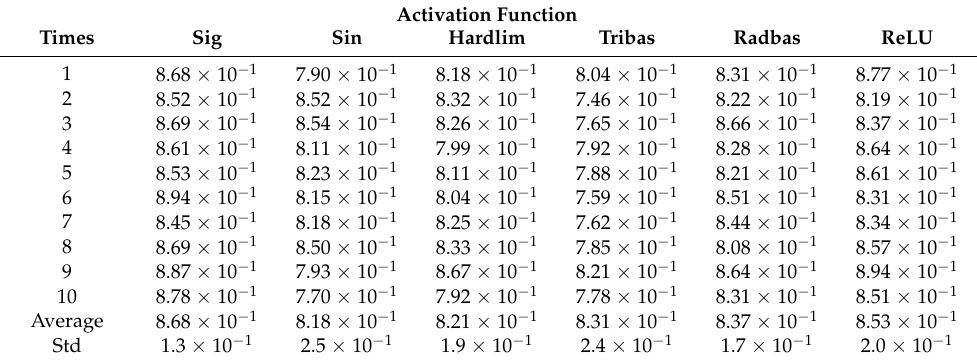
Table A2. Influence of activation function on prediction accuracy.